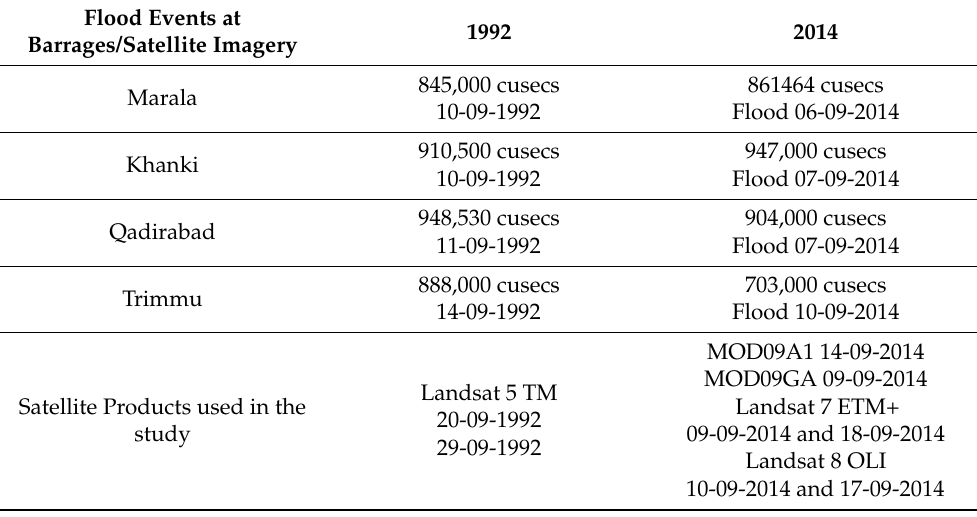
Table 2. Flood events and satellite products used for water bodies delineation. Flood Events